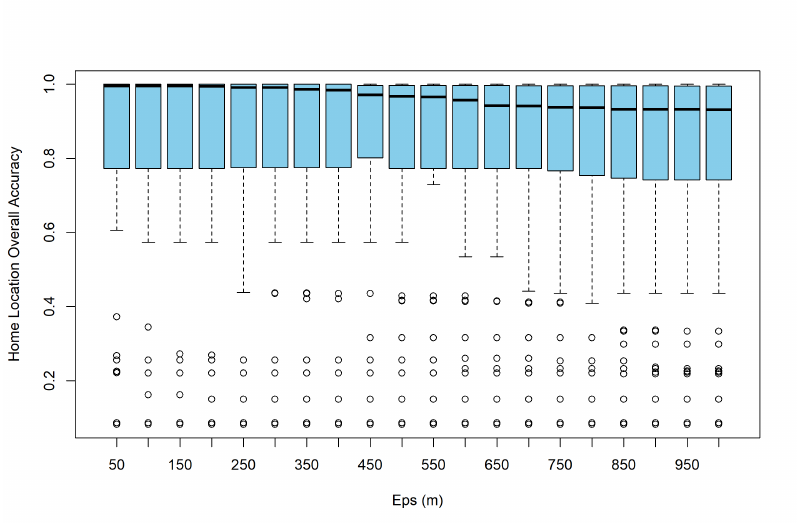
Figure 3: The boxplot of overall accuracy changes of home cluster detection with different DBSCAN parameters (without